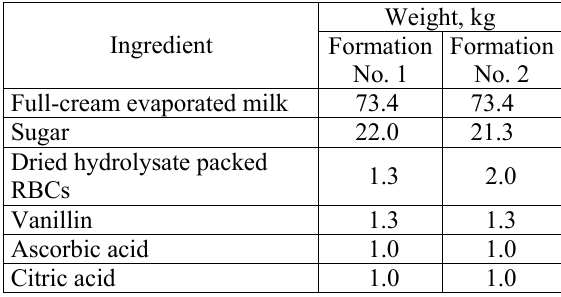
Table 7. Organoleptic properties of bar with anti-